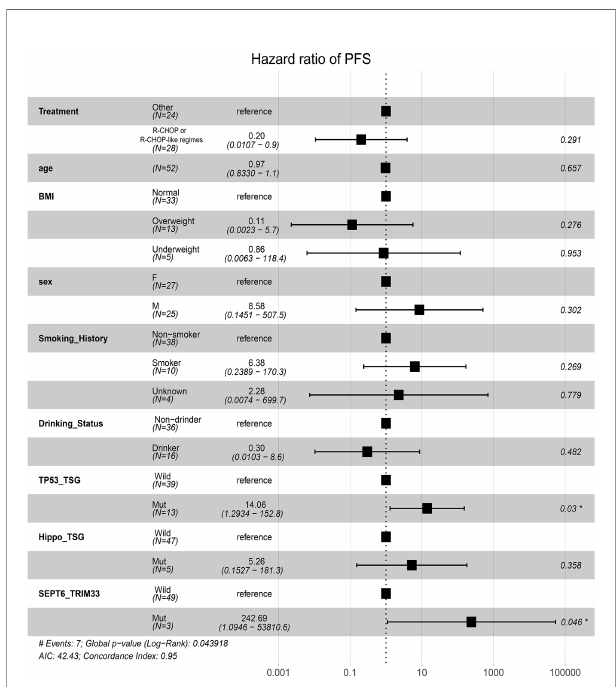
FIGURE 5 | Prognostic signi fi cances of fusion gene, mutated pathways, and clinic factors by multivariable Cox proportional hazards regression